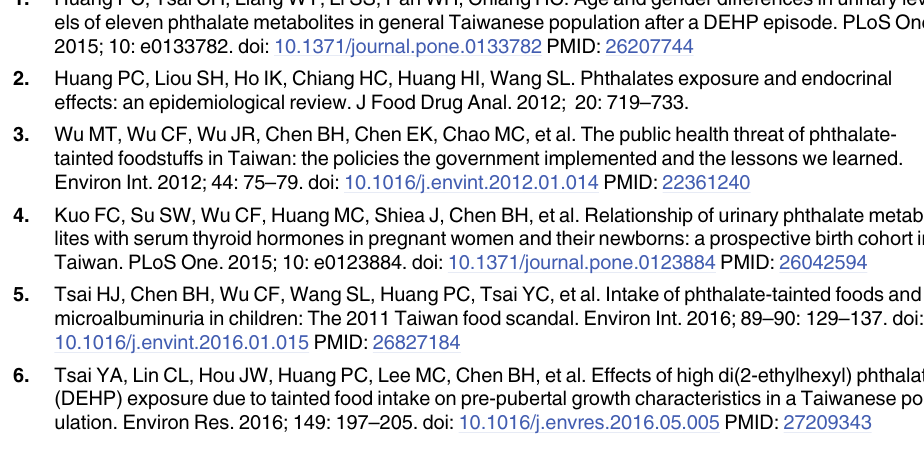
S1 Table. Pearson correlation coefficients between levels of creatinine unadjusted and cre- atinine adjusted phthalate metabolites. S2 Table. Comparison of urinary phthalate metabolites (ng/mL) in pregnant women of Taiwan and other